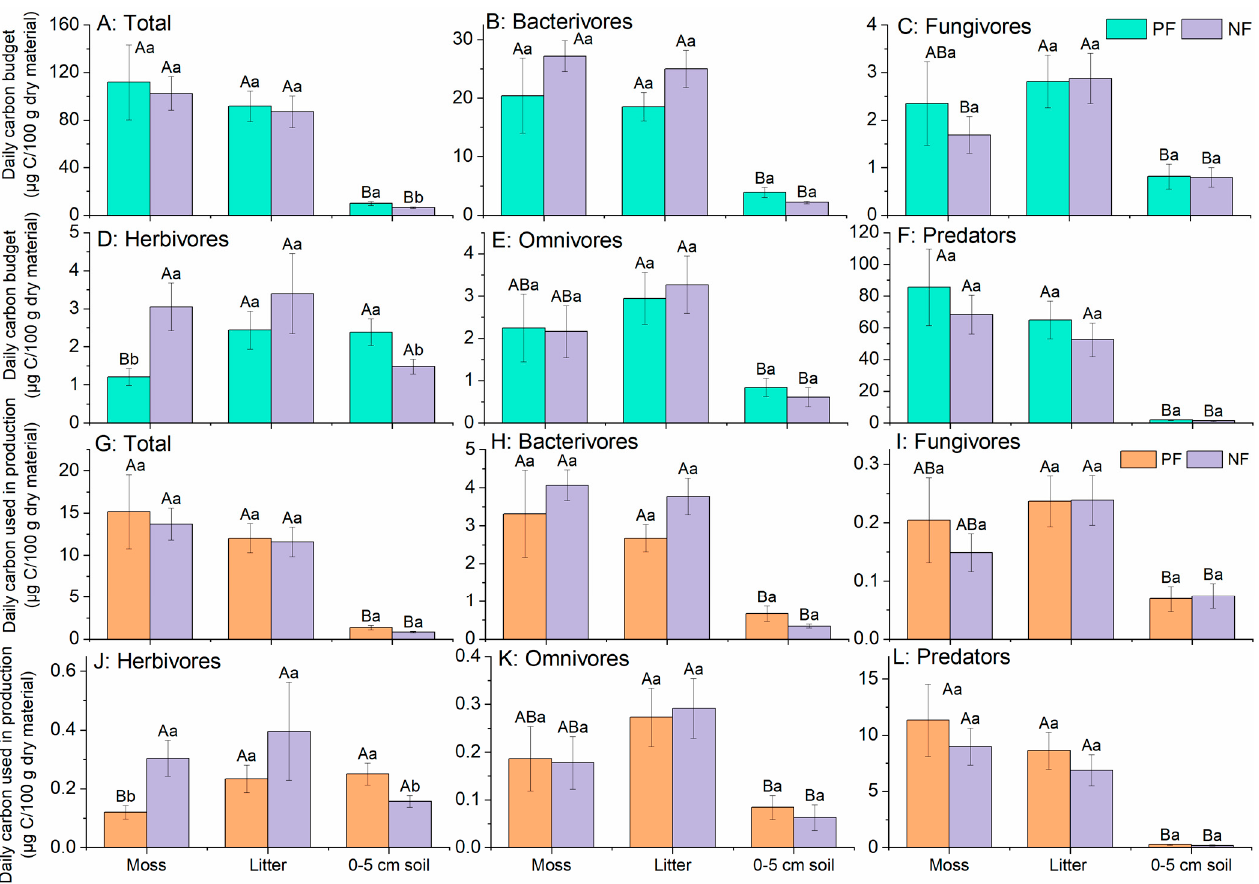
Figure 4. Daily carbon budget ( A – F ) and daily carbon used in production ( G – L ) of nematodes in total and different trophic groups in subalpine spruce forests. Upper-case letters indicate significant differences among the three layers; lower-case letters indicate significant differences between the two forest types.